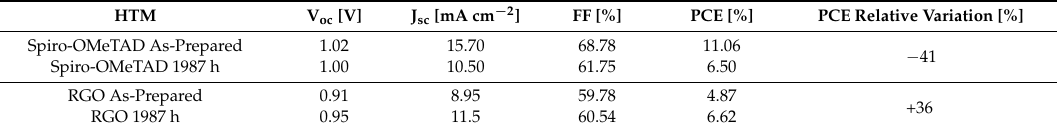
Figure 8. ( a ) J–V characteristics and ( b ) EQE spectrum of the champion device with graphene/graphene oxide (GO) layer [65]. Table 3. Device stability test results (1987 h) for both kinds of PSCs (perovskite solar cells) [68].